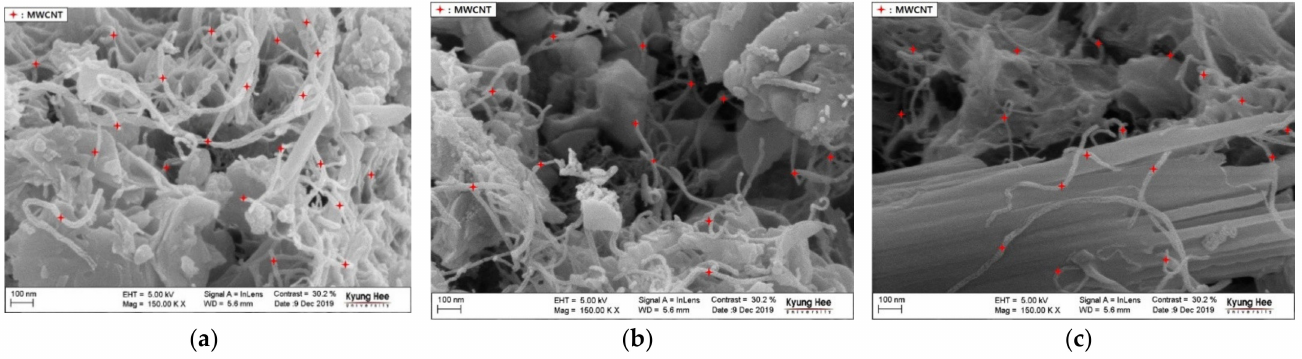
Figure 13. Field emission scanning electron microscopy (FE-SEM) images: ( a ) 0.5 wt% cement paste, ( b ) 0.5 wt% mortar, and ( c ) 0.5 wt%